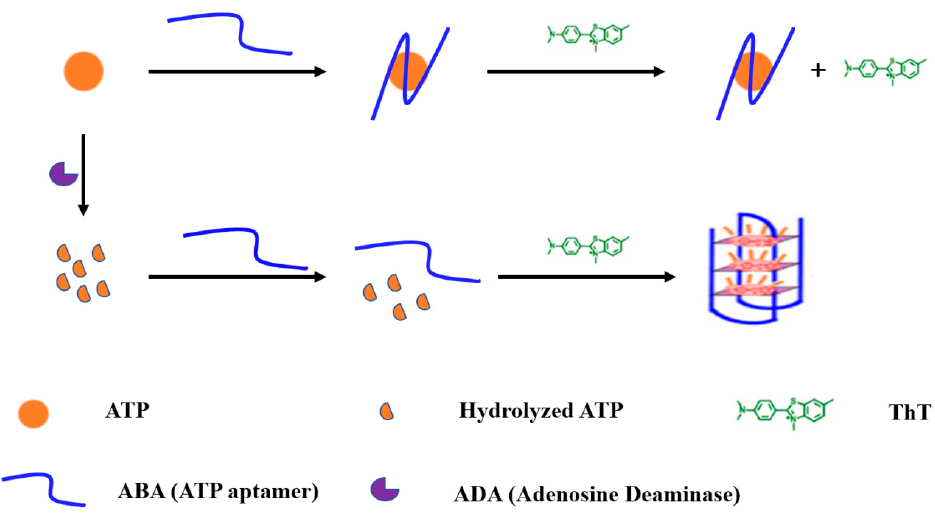
Figure 1. Schematic illustration of the fluorescence sensor for the detection of ADA. In the absence of ADA, the ATP aptamer could bind with ATP and showed a low fluorescence signal. With the addition of ADA, ATP was hydrolyzed. Hence, ATP aptamer could form a G-quadruplex/thioflavin T (ThT) complex with ThT and exhibited an obvious fluorescence